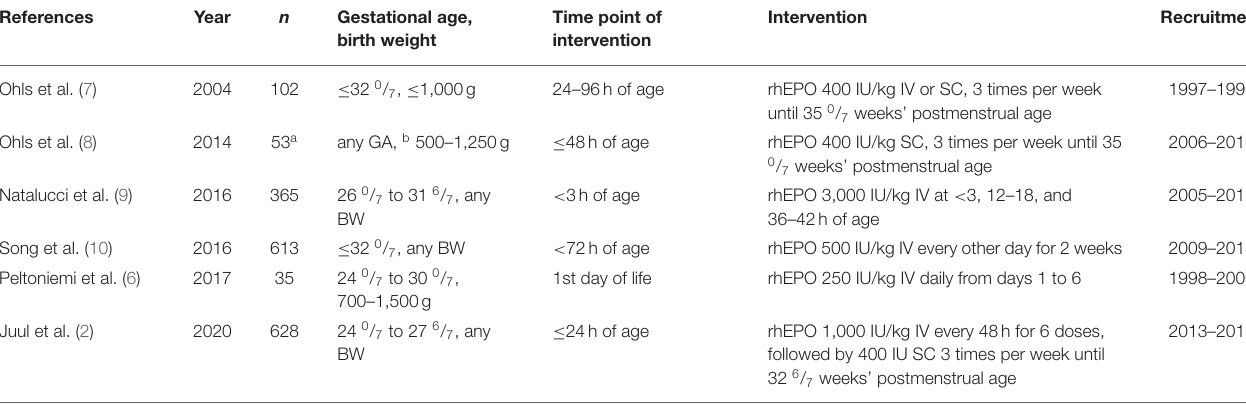
TABLE 1 | Characteristics of included